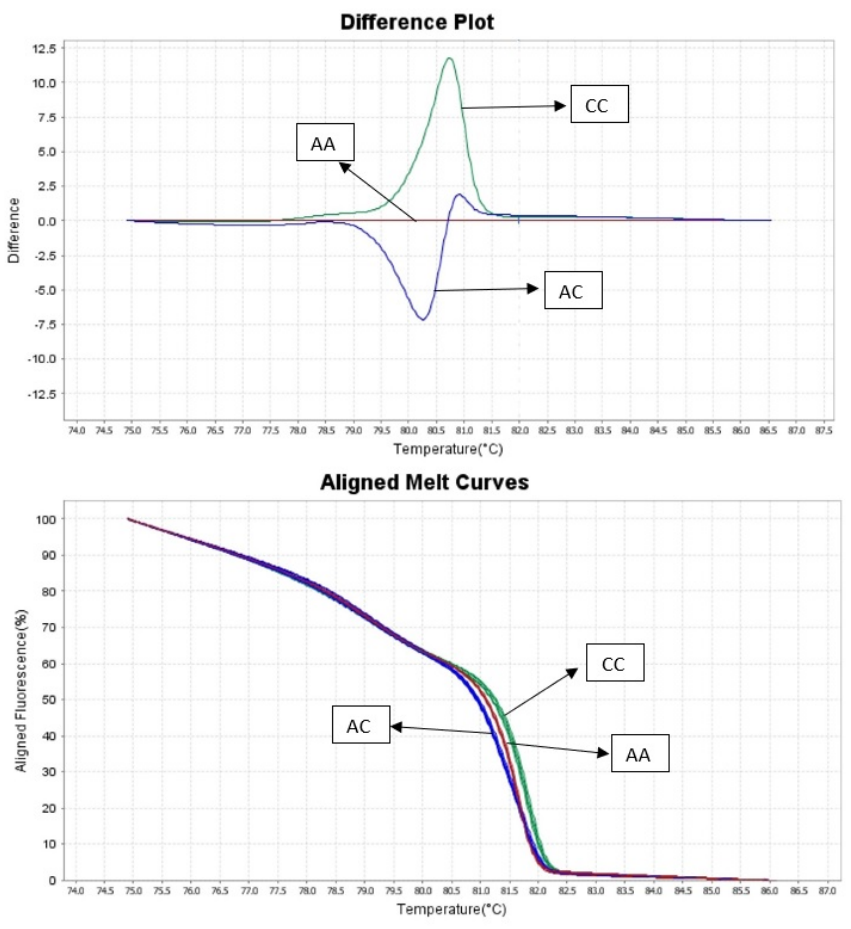
Figure 2. HRM genotyping results.